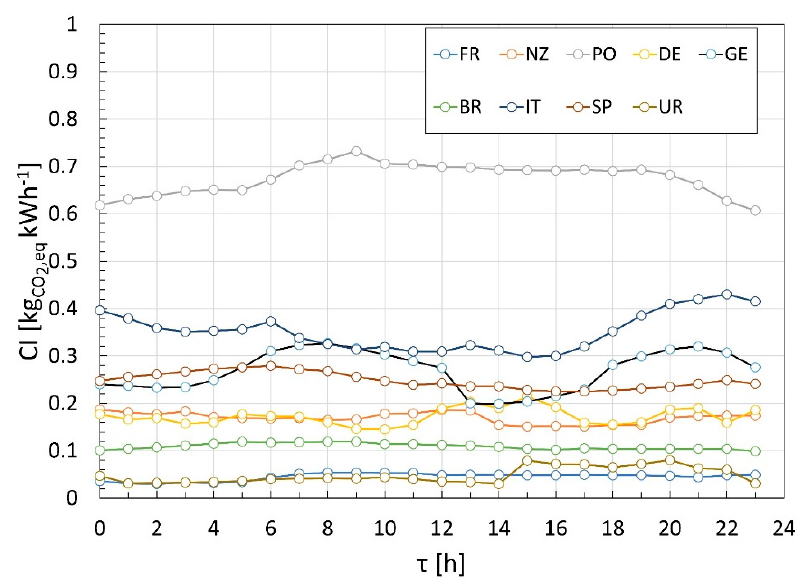
Figure 2. Hourly carbon intensity profiles for different countries during a day of June (based on data from Tomorrow [45]).